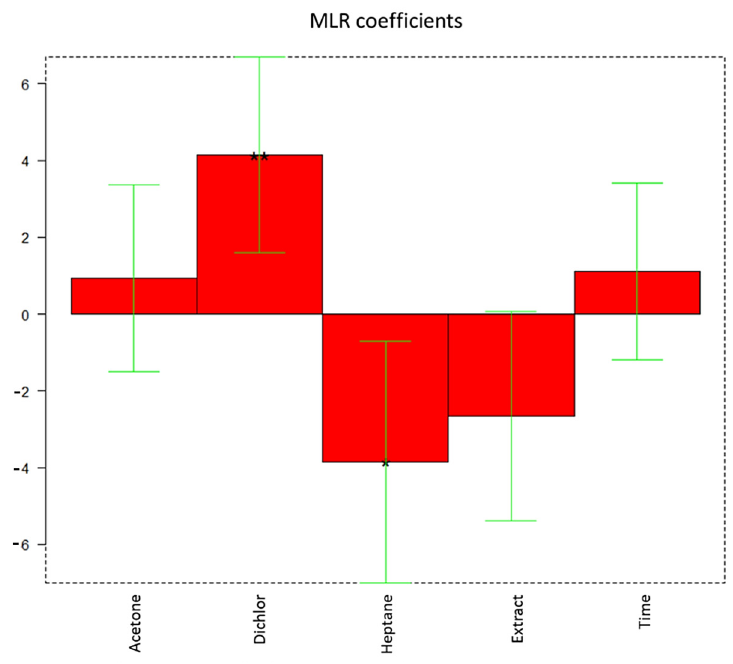
Figure 2. Significance of the experimental parameters in terms of MLR coefficients from the D-optimal analysis. The * and ** symbols indicate the significant p -values lower than 0.05 and 0.01, respec- tively.